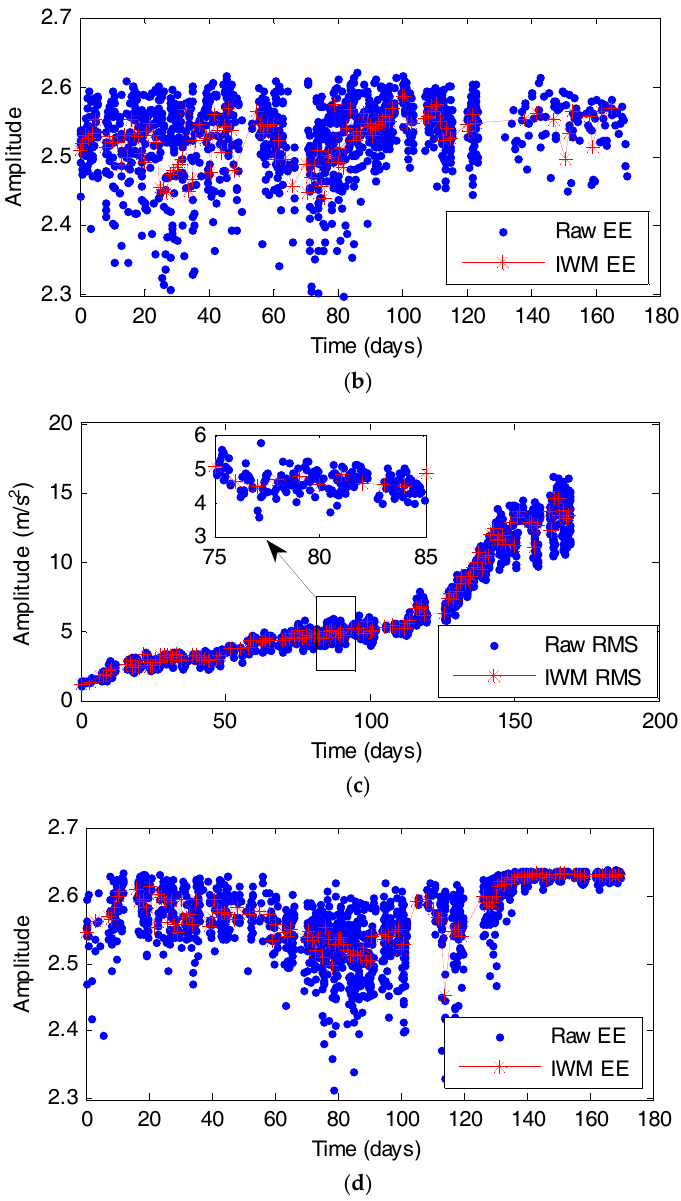
Figure 15. The raw and whiten health indicators: ( a ) RMS of training datasets; ( b ) EE of training datasets; ( c ) RMS of testing datasets; ( d ) EE of testing datasets.